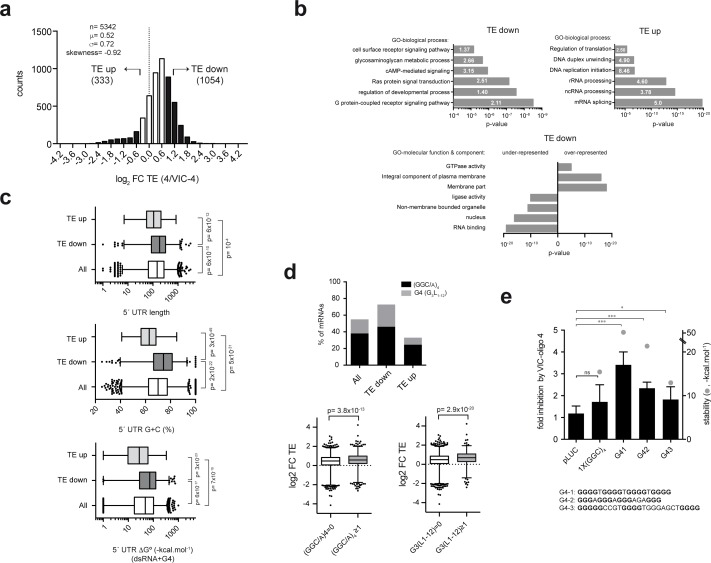
Genome-wide effect of ES6S blockage on translation.(a) Distribution of translational changes induced by VIC–oligo 4 transfection of HEK293T cells. Only mRNAs showing a p-adj <0.05 between replicas were selected; data are expressed as log2 fold change (FC) of translation efficiency (TE) (4/VIC-4). The tails of the distribution with FC TE >1 (TE down) and FC TE <−0.7 (TE up) were selected for further analysis. (b) Gene ontology (GO) analysis of the ‘TE down’ and ‘TE up’ groups, showing the six terms (biological processes) with the highest significance (p-value) and fold-enrichment (numbers within the bars) (upper panels). The lower panel shows the differential enrichment of the 'TE down' group in terms of GO-molecular function and GO-molecular component. The under- and over-represented terms are shown. (c) Analysis of the 5′ UTR features of mRNAs in TE groups. The length, G+C composition and RNA structure content of 5′ UTRs were analyzed and compared among groups using the Mann-Whitney U test (p-values are shown). (d) Differential enrichment in the (GGC/A)4 and G4 (G3L1-12) motifs found in the 5′ UTR of ‘TE down’ mRNAs. Data represent the accumulated percentage of mRNAs that show at least one of the indicated motifs (left panel); p-value<10−5 after χ2 test. The lower panel shows a box plot of the log2 FC TE of mRNAs showing at least one (GGC/A)4 motif (left) or one G4 (G3L1-12) motif (right) compared with the corresponding subset of mRNA showing no motifs. The p-values generated by U tests are shown. (e) Effect of VIC–oligo 4 on the translation of Luc mRNAs bearing the indicated motifs in the 5′ UTR. Translations were carried out in RRL as described in the Materials and methods. Data represent the mean ± SD of six (pLuc and 1x(GGC)4) or three (G41, G42 and G43) independent experiments. The calculated stability of the motifs is shown as ΔG° (-kcal.mol−1, gray dots); the sequences of the G4 motifs are also indicated (bottom).